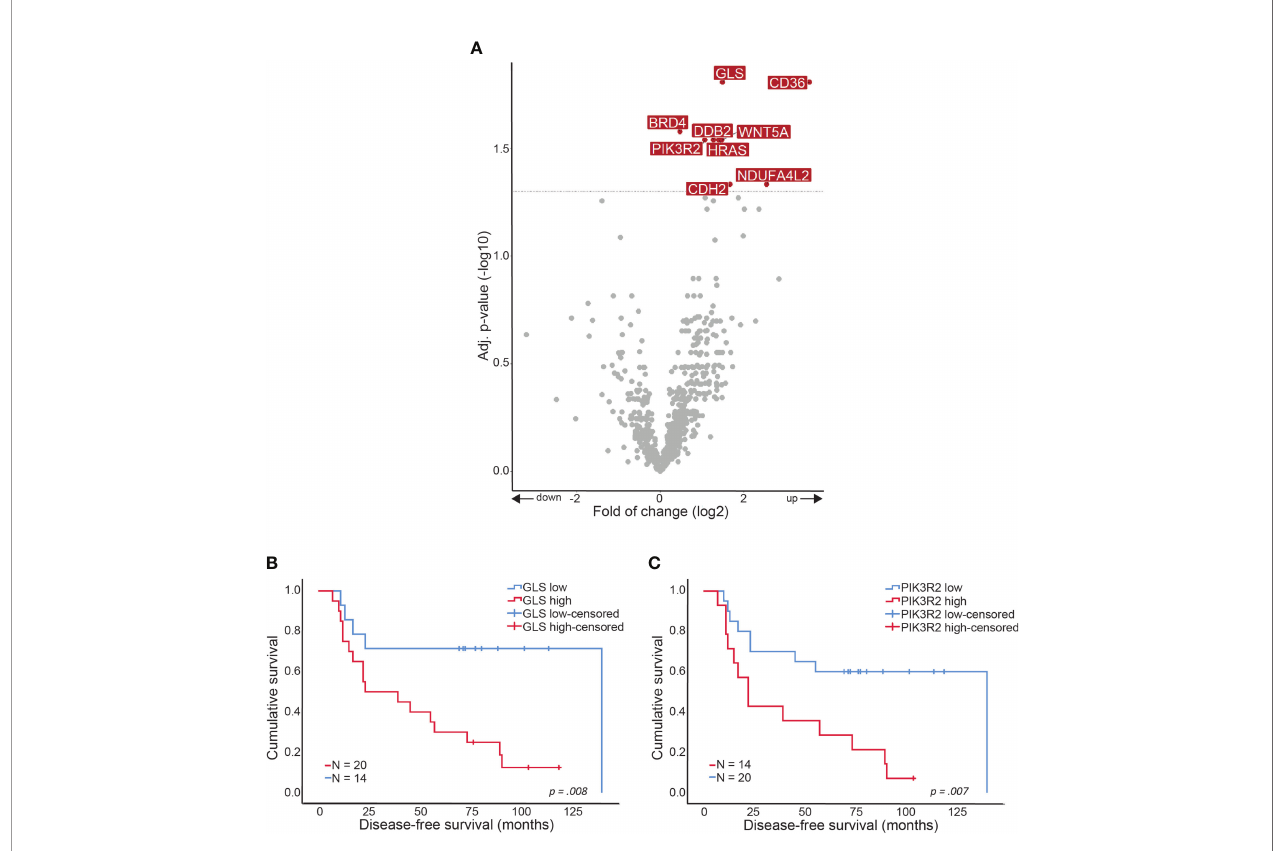
FIGURE 2 | Gene expression alterations in CCDR. Volcano plot showing over- and underexpressed genes in CCDR. Each dot represents a gene of the nCounter ® PanCancer IO 360 Gene Expression Panel. Y-axis: p-values after the Benjamini-Hochberg procedure (-log10 scale). X-axis: Fold of change is calculated with CCNR as baseline reference (log2 ratio). Arrows indicate up- or downregulation. Kaplan-Meier curves showing disease-free survival in months related to gene expression. (A) CCDR vs. CCNR (B) GLS gene expression and (C) PIK3R2 gene expression. CCNR, Cervical cancer no recurrence; CCDR, Cervical cancer distant